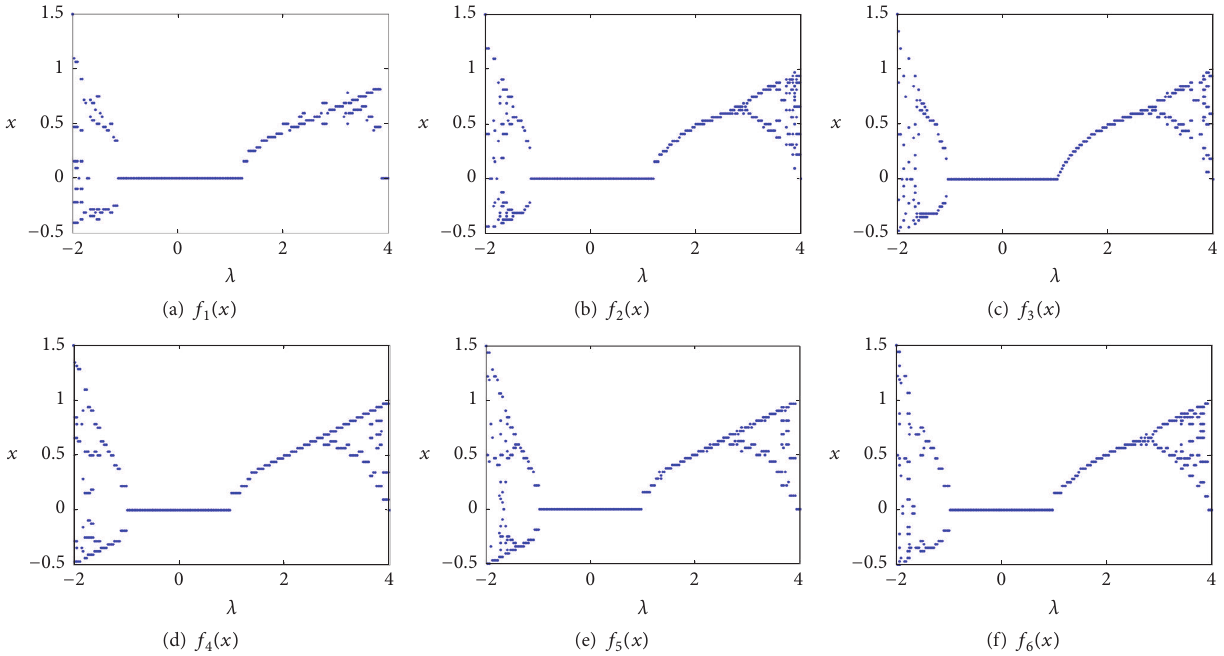
Figure 3: Bifurcation diagram versus the control parameter 𝜆 for six different orders starting at 𝑥 0 = 0.5 at 𝑝 = 9 ( 𝑝 𝑓 = 5 bits).